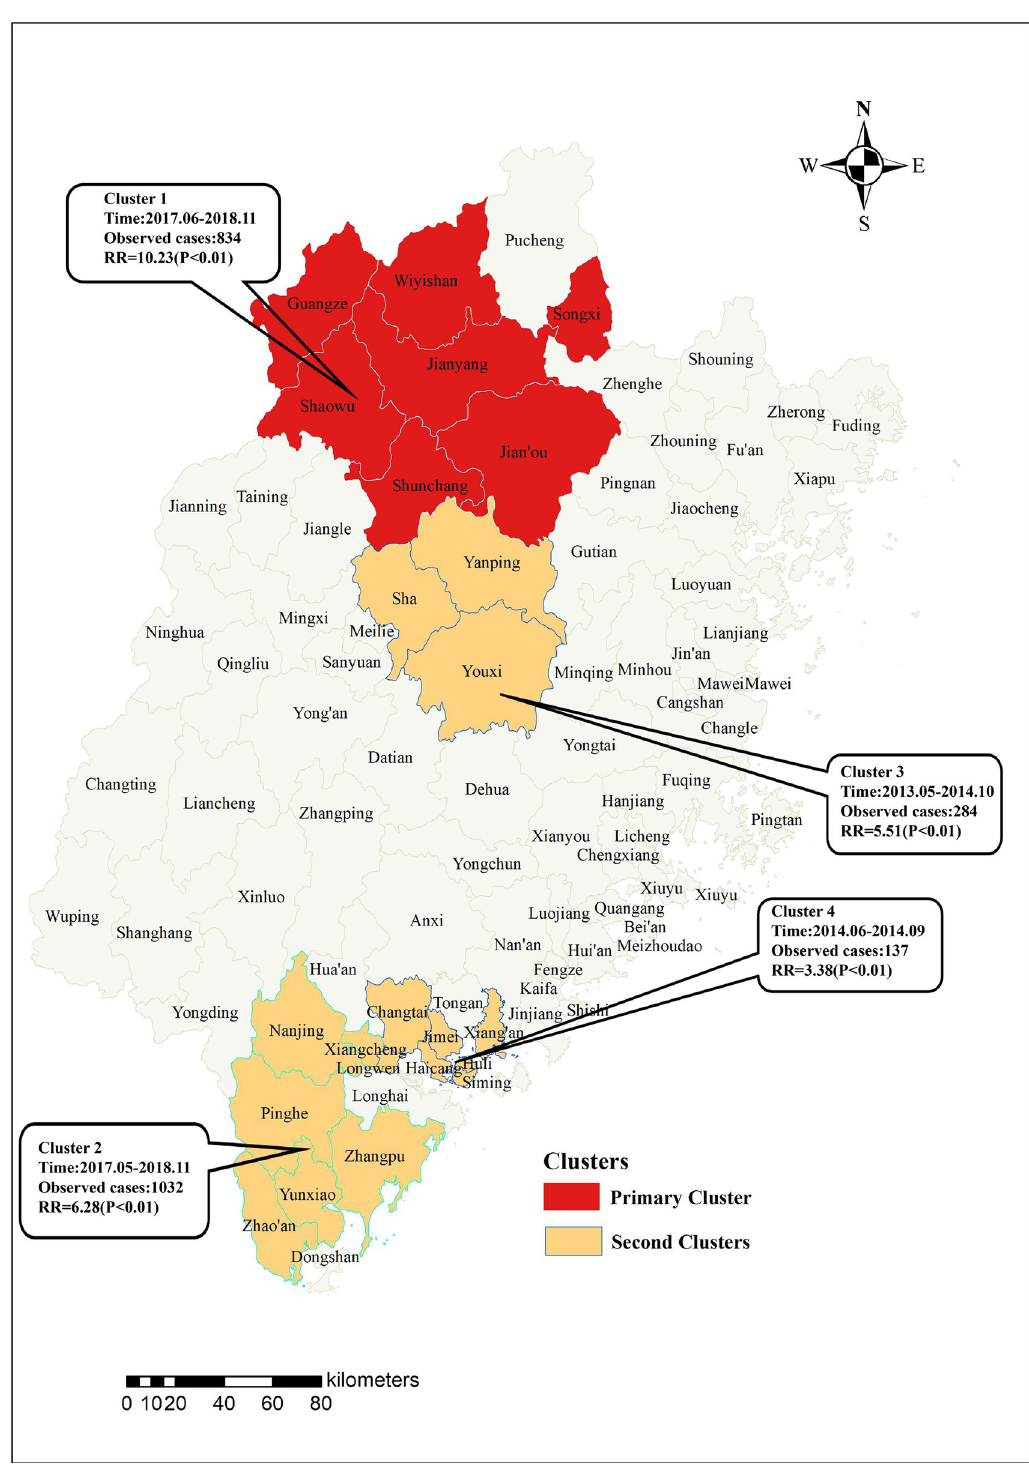
Fig 5. Spatiotemporal clusters of scrub typhus cases at the county level across the period of 2012–2020 in Fujian Province. The base layer of the map was obtained from Resource and Environment Science and Data Center (https://www.resdc.cn/